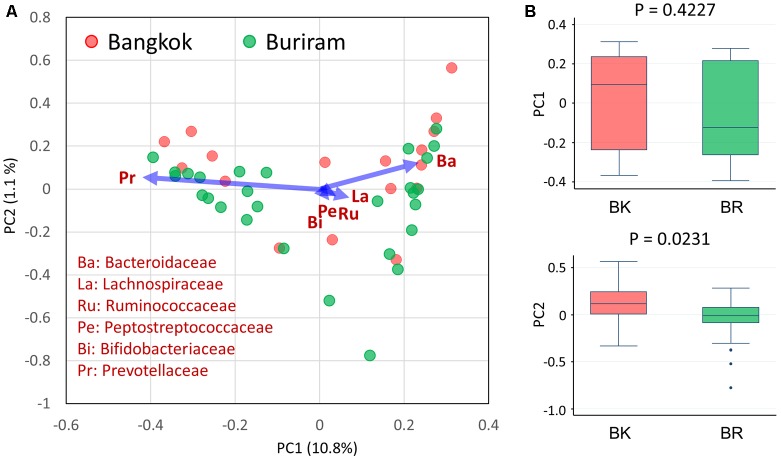
Principal component analysis (PCA) of fecal bacterial community profiles (family level) of children in Bangkok and Buriram. (A) PCA plot of 17 Bangkok and 28 Buriram children. (B) PC1 (upper) and PC2 (lower) sample distributions. The probability value (p) was determined by Wilcoxon rank-sum test. Refer to Figure 1D for a description of the box plot.